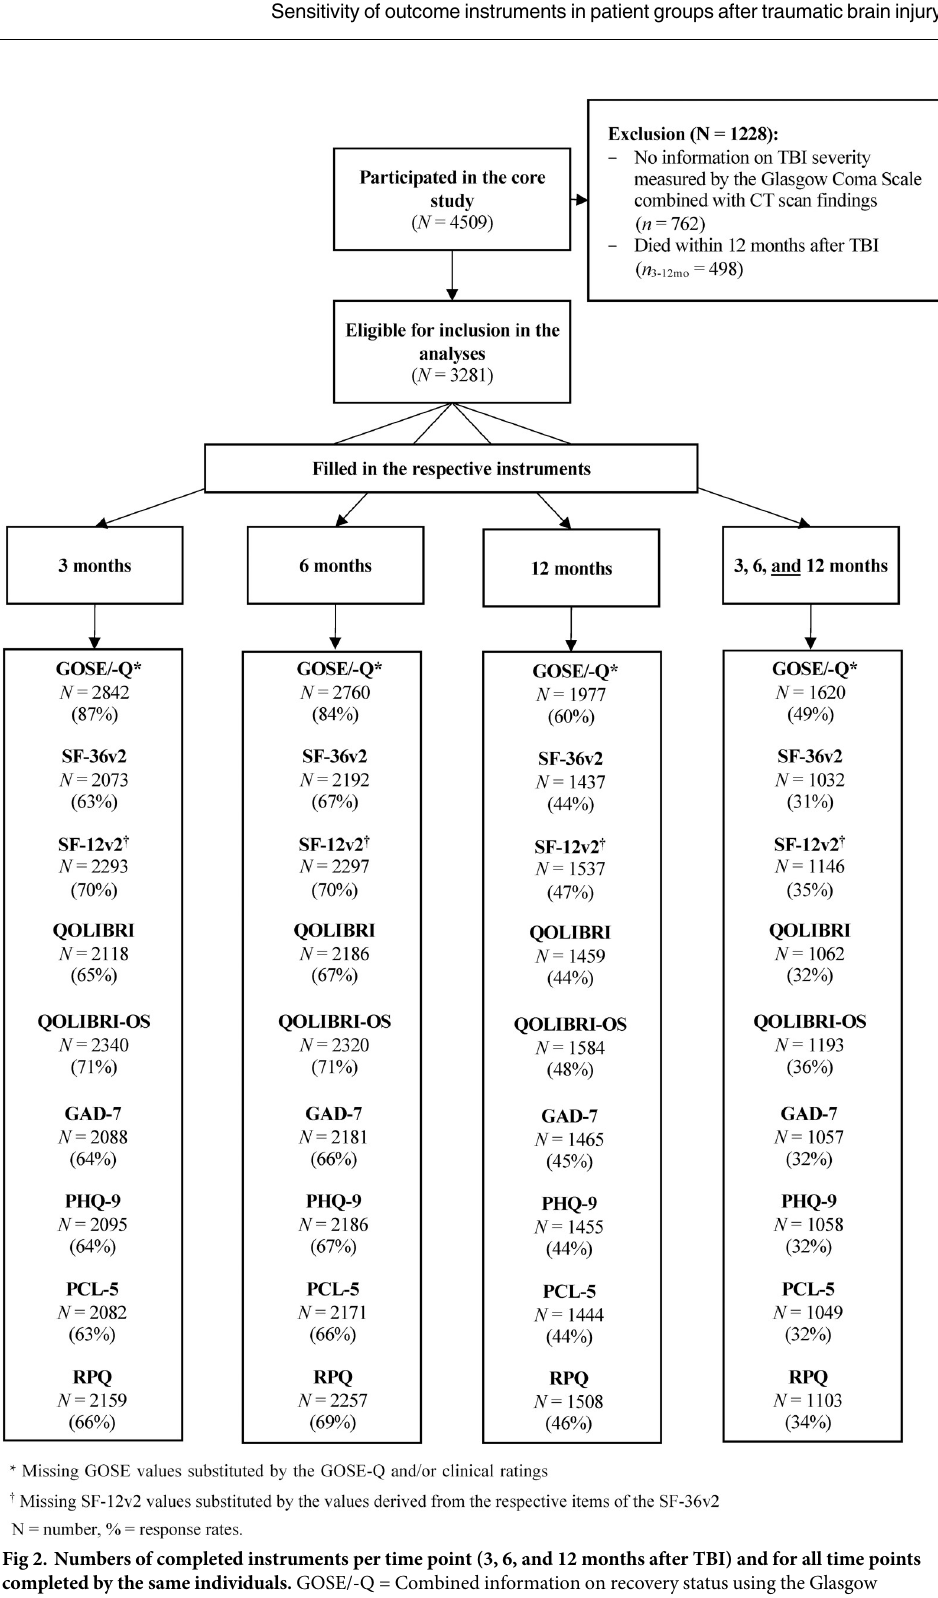
PLOS ONE | https://doi.org/10.1371/journal.pone.0280796 April 7,